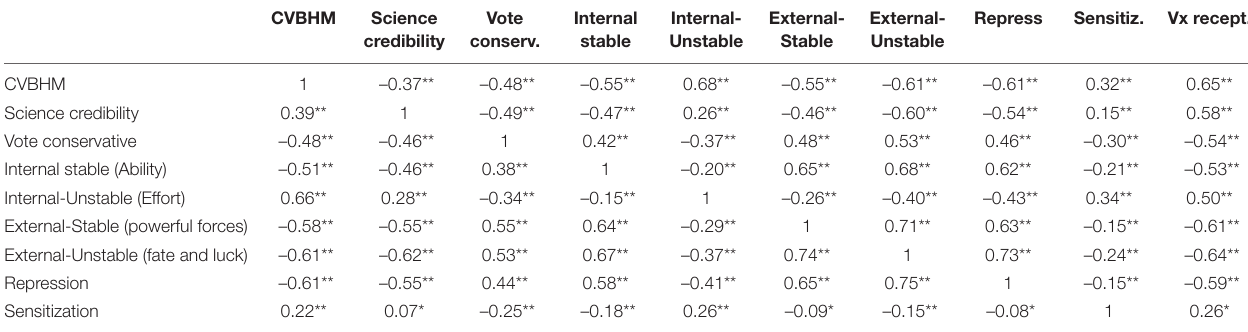
TABLE 4 | Correlations among psychological variables for Pre-Vx and Mid-Vx samples (Study 1).